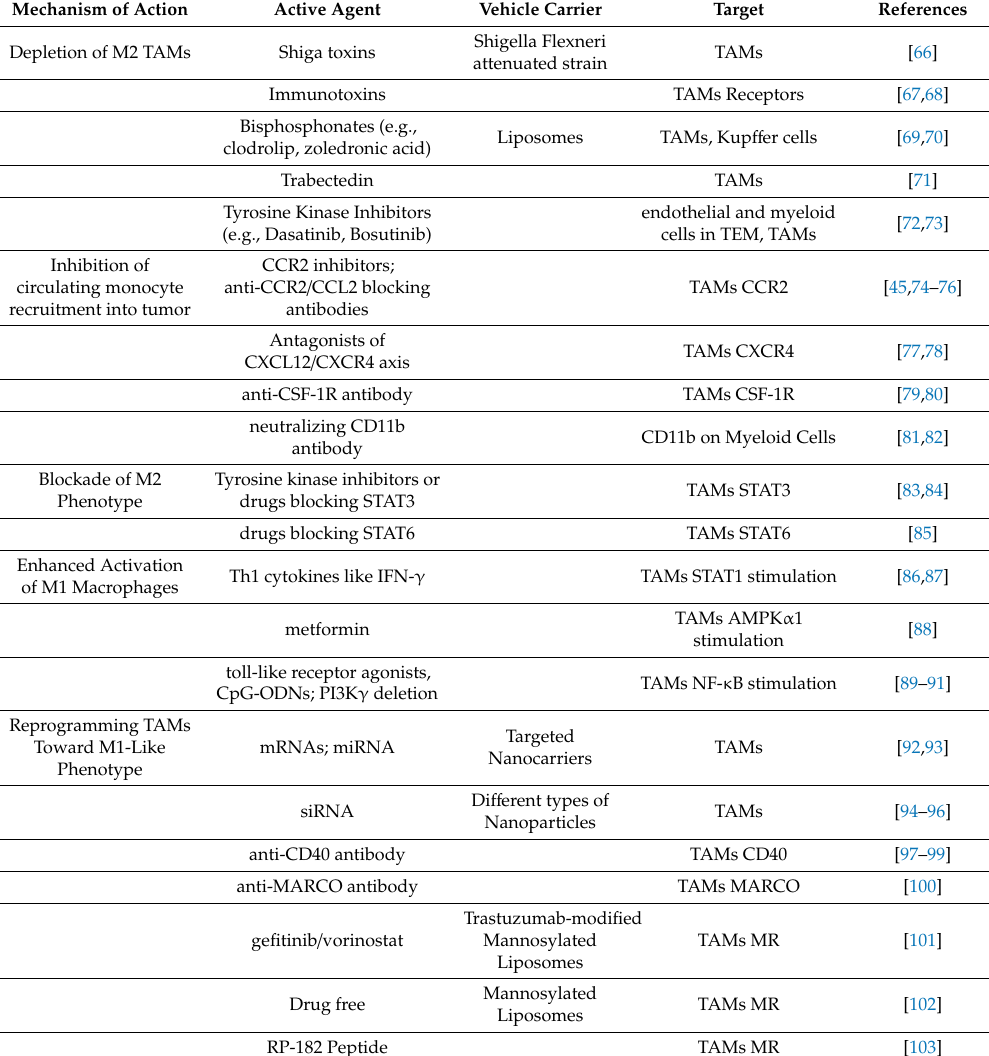
Table 1. Selected strategies to target tumor-associated macrophages